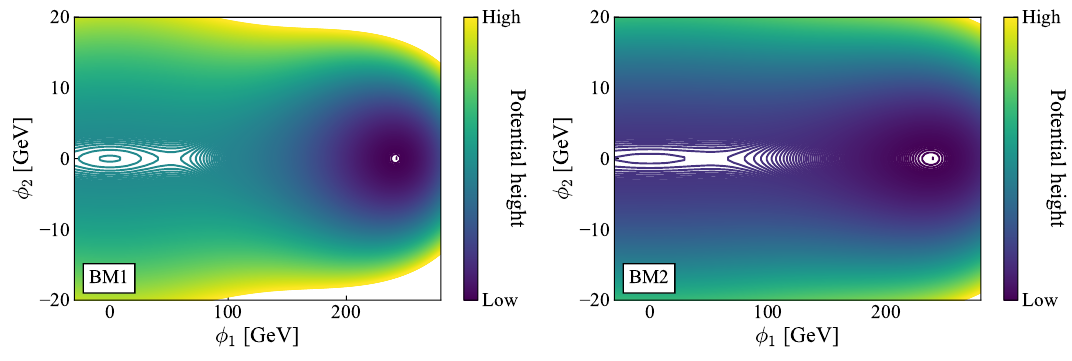
Figure 3 . Contours of the finite temperature effective potential V T at T = T n for the BM1 (left) and BM2 (right). The nucleation temperature is determined as T n = 23 GeV for BM1 and 25 GeV for BM2. The first-order PT occurs from the origin to the EW vacuum in both benchmark parameter sets.